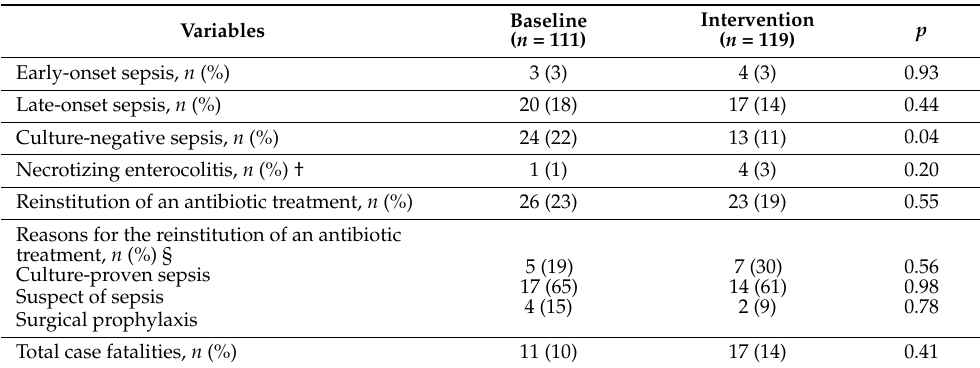
Table 4. Sepsis, necrotizing enterocolitis, and reinstitution of antibiotic treatments at baseline and in the intervention